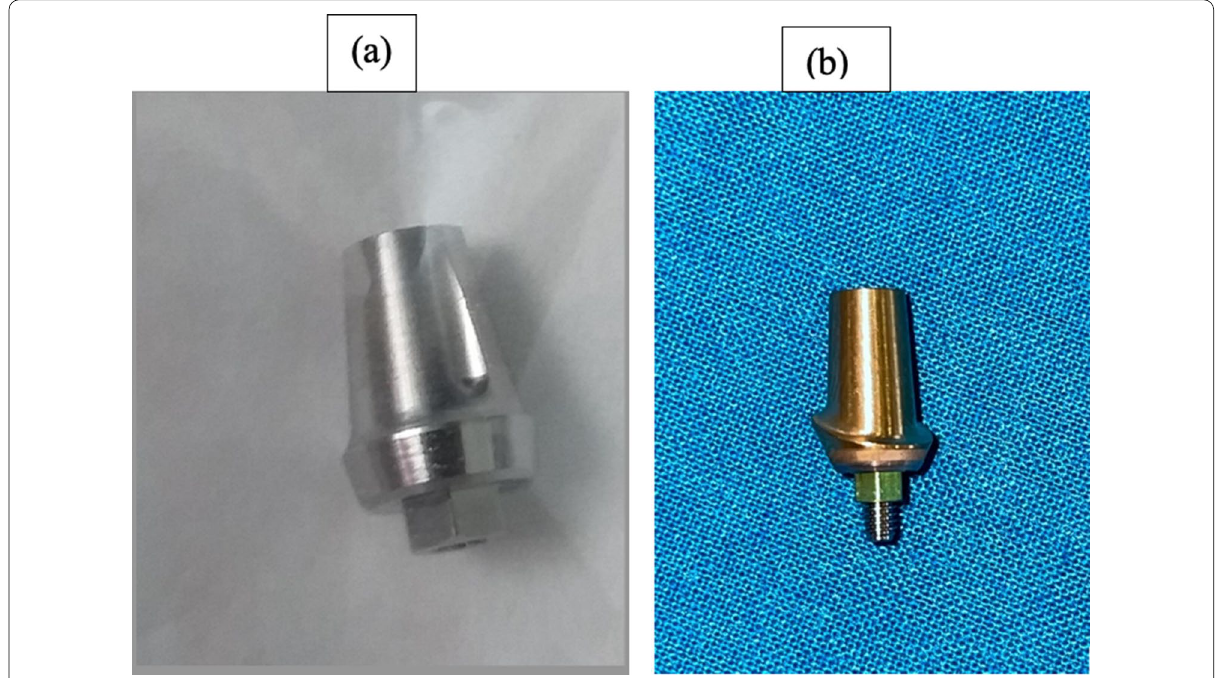
Fig. 2 Prosthetic abutments used for loading. a Regular Machined abutments, b Laser microgrooved